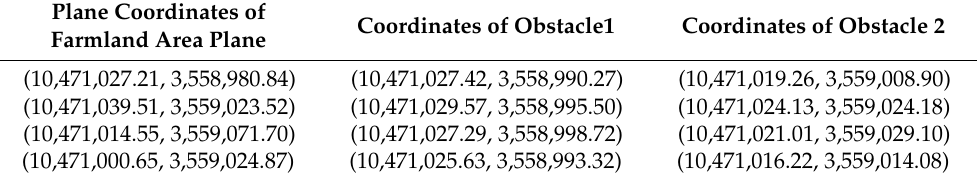
Table 10. Coordinate mapping to Figure 13b. Farmland Mapping Coordinates